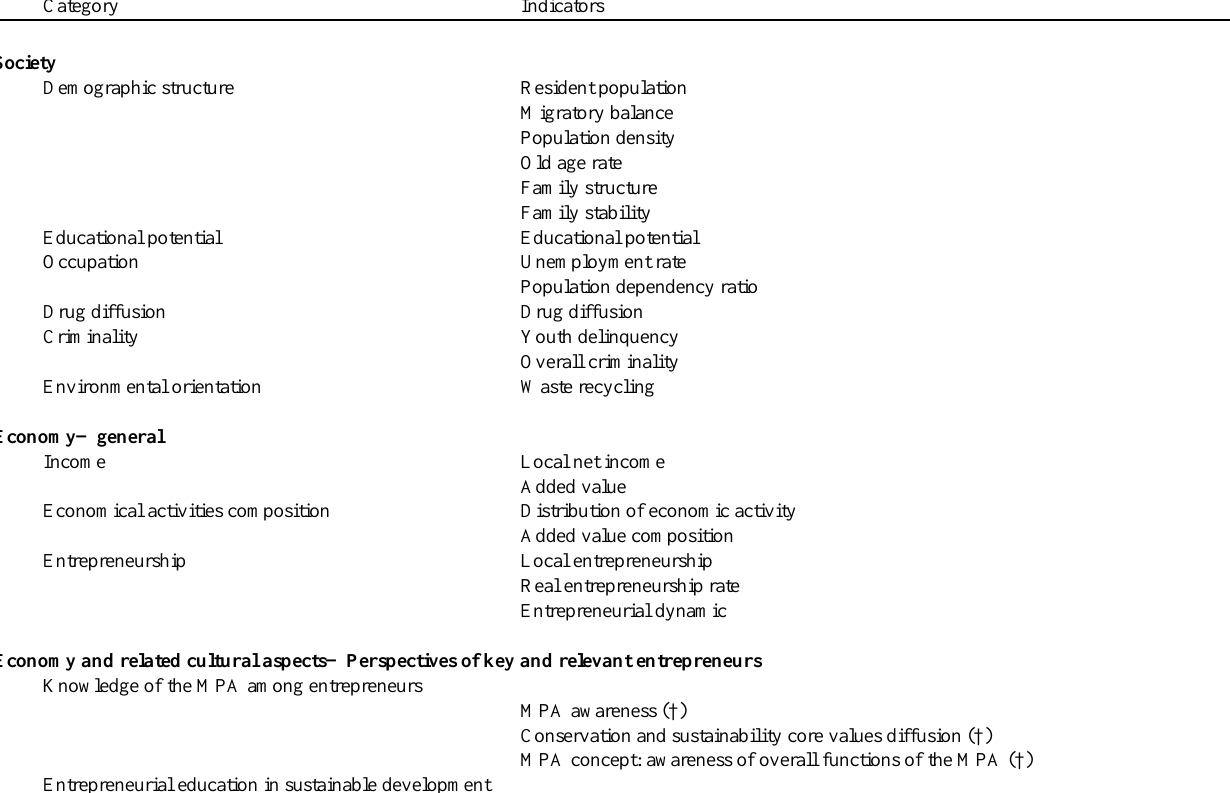
Table 1 . Main indicators used in the analysis (†: indicators quantified through